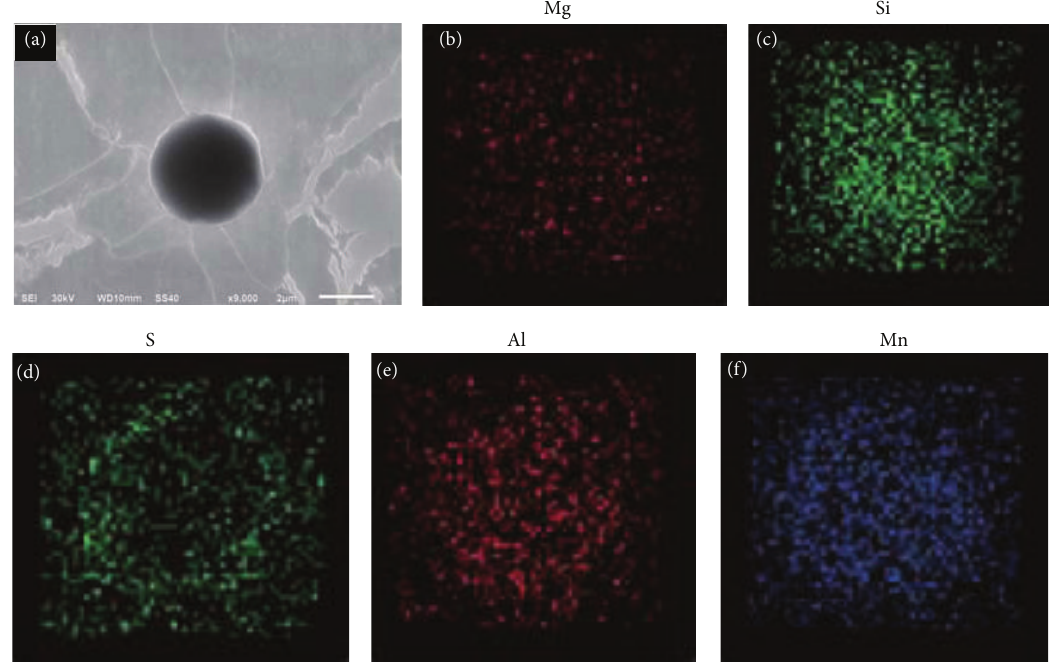
Figure 4: SEM micrograph (a) and EDS mapping images of various elements ((b): Mg; (c): Si; (d): S; (e): Al; (f): Mn) for the inclusion in etched sample.